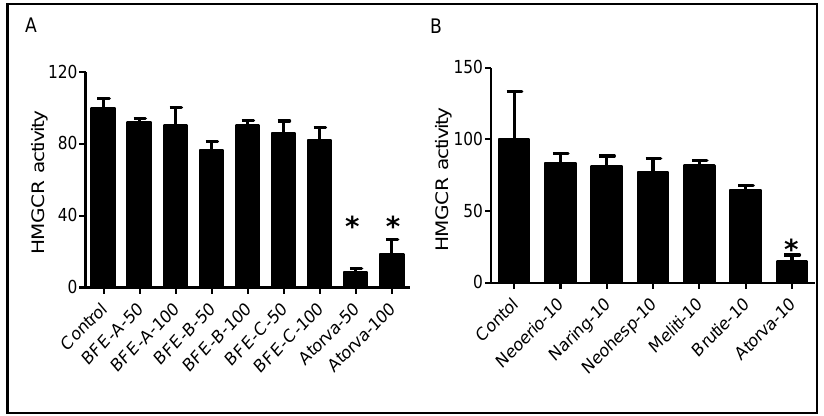
Figure 3. Effect of BFE ( A ) and its principal components ( B ) at indicated concentrations on HMGCR activity in vitro. Results are from three independent experiments and expressed as the mean ± SE. *: p < 0.05 compared with control group. BFE-A-50, bergamot fruit extract A 50 μg/mL; BFE-A-100, bergamot fruit extract A 100 μg/mL; BFE-B-50, bergamot fruit extract B 50 μg/mL; BFE-B-100, bergamot fruit extract B 100 μg/mL; BFE-C-50, bergamot fruit extract C 50 μg/mL; BFE-C-100, bergamot fruit extract C 100 μg/mL; Atorva-50, atorvastatin 50 μM; Neoerio-10, neoeriocitrin 10 μM; Naring-10, naringin; Neohesp-10, neohesperidin; Meliti-10, melitidin; Brutie-10, brutieridin; Atorva-10, atorvastatin 10 μM.